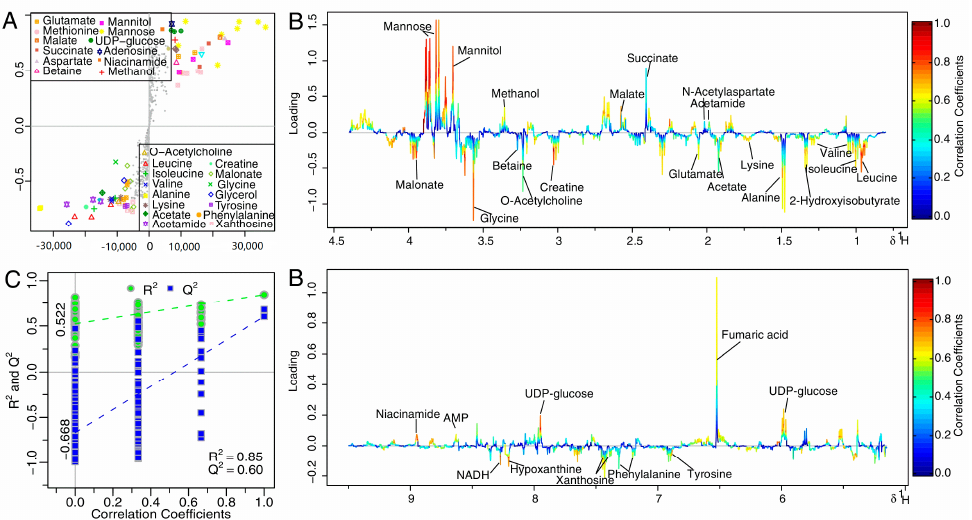
Figure 5. S-plot ( A ) and loadings plot with the metabolites labeled; ( B ) corresponding to the OSC-PLS-DA analysis from the CK and treatment groups at 12 h; ( C ) OSC-PLS-DA scatter plots of statistical validation obtained by 200 times permutation test, with R 2 and Q 2 values in the vertical axis, the correlation coefficients (between the permuted and true class) in the horizontal axis, and the ordinary least squares (OLS) line for the regression of R 2 and Q 2 on the correlation coefficients. Intercepts: R 2 = (0.00, 0.522), Q 2 = (0.00, − 0.668).